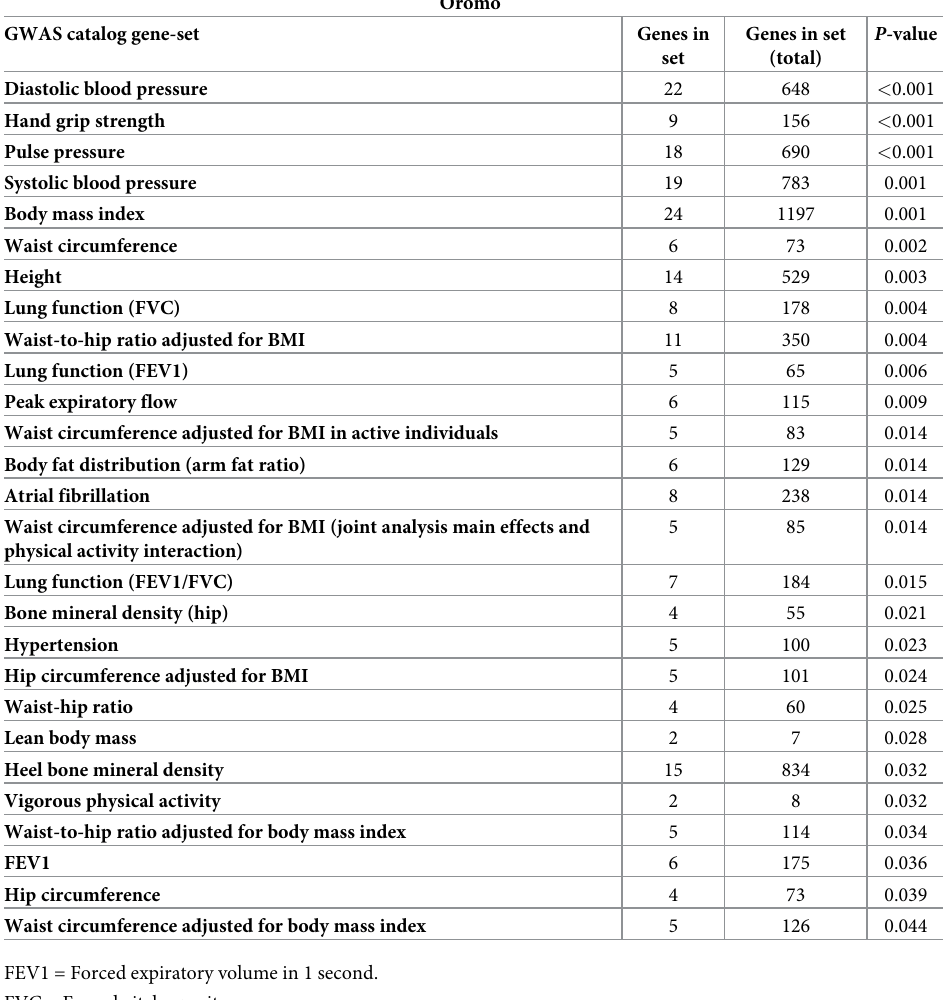
FEV1 = Forced expiratory volume in 1